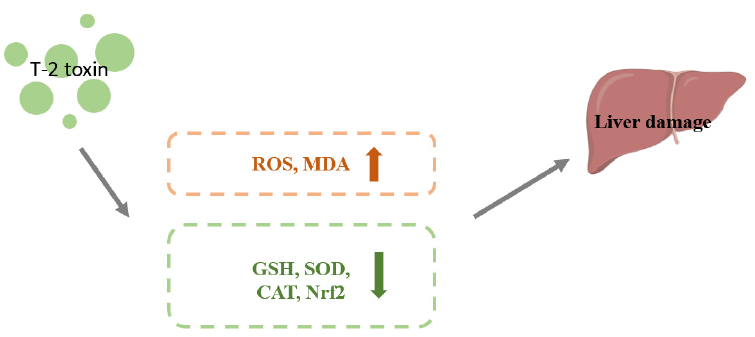
Figure 4. Mechanism of hepatotoxicity induced by T-2 toxin. T-2 toxin leads to increased ROS and MDA contents and decreased expression of GSH, SOD, CAT and Nrf2, which leads to liver dam-